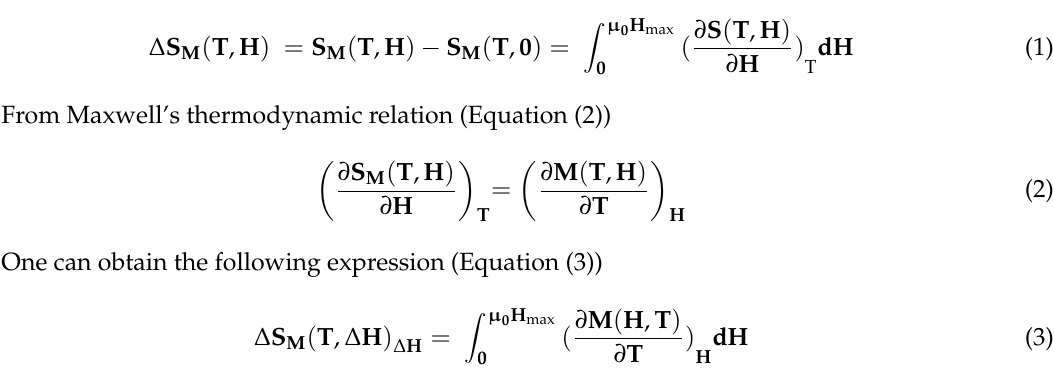
Figure 7. Isothermal magnetic entropy change around the Curie temperature for Er 6 Fe 20 Al 3 ( a ) and Er 6 Fe 23 ( b ) compounds.